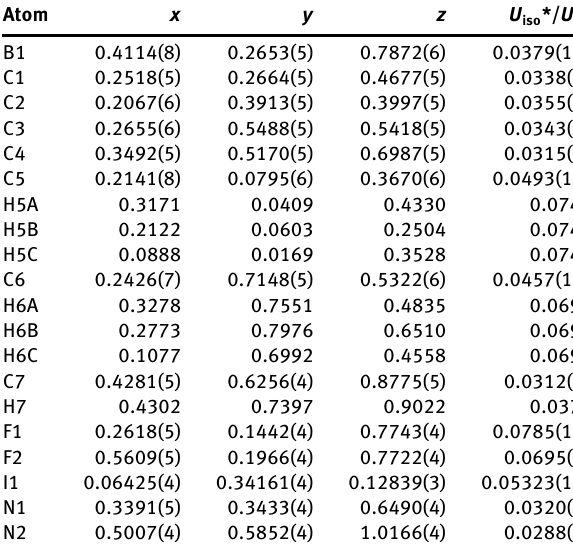
Table 2: Fractional atomic coordinates and isotropic or equivalent isotropic displacement parameters (Å 2